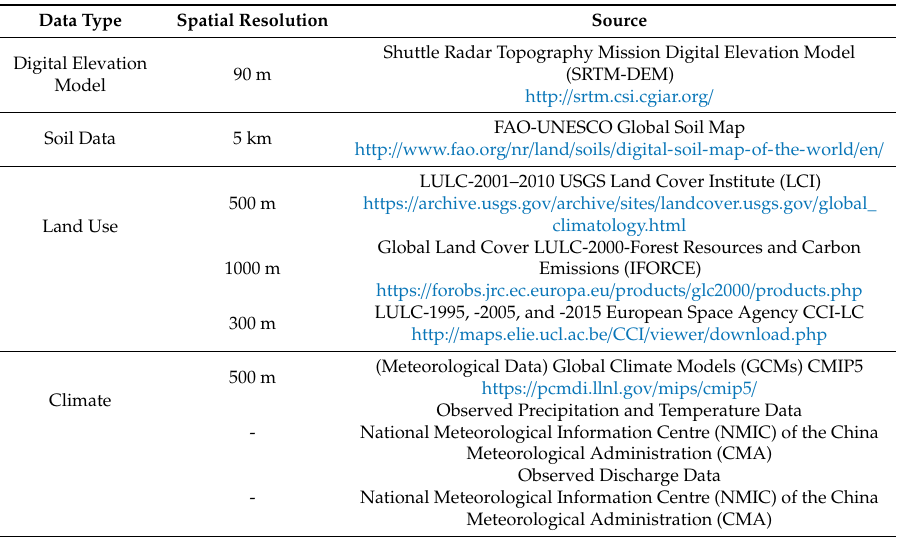
Figure 1. Map of the Upper Xijiang River Basin. Table 1. Summary of data description and